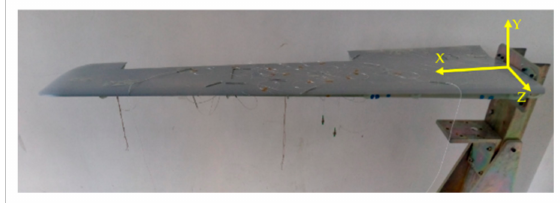
Figure 12. Variable-section wing physical